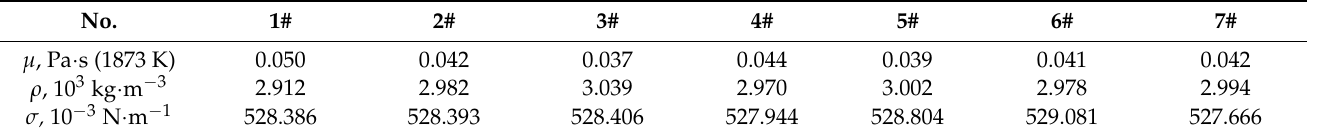
Table 4. Physical parameters of the slags.